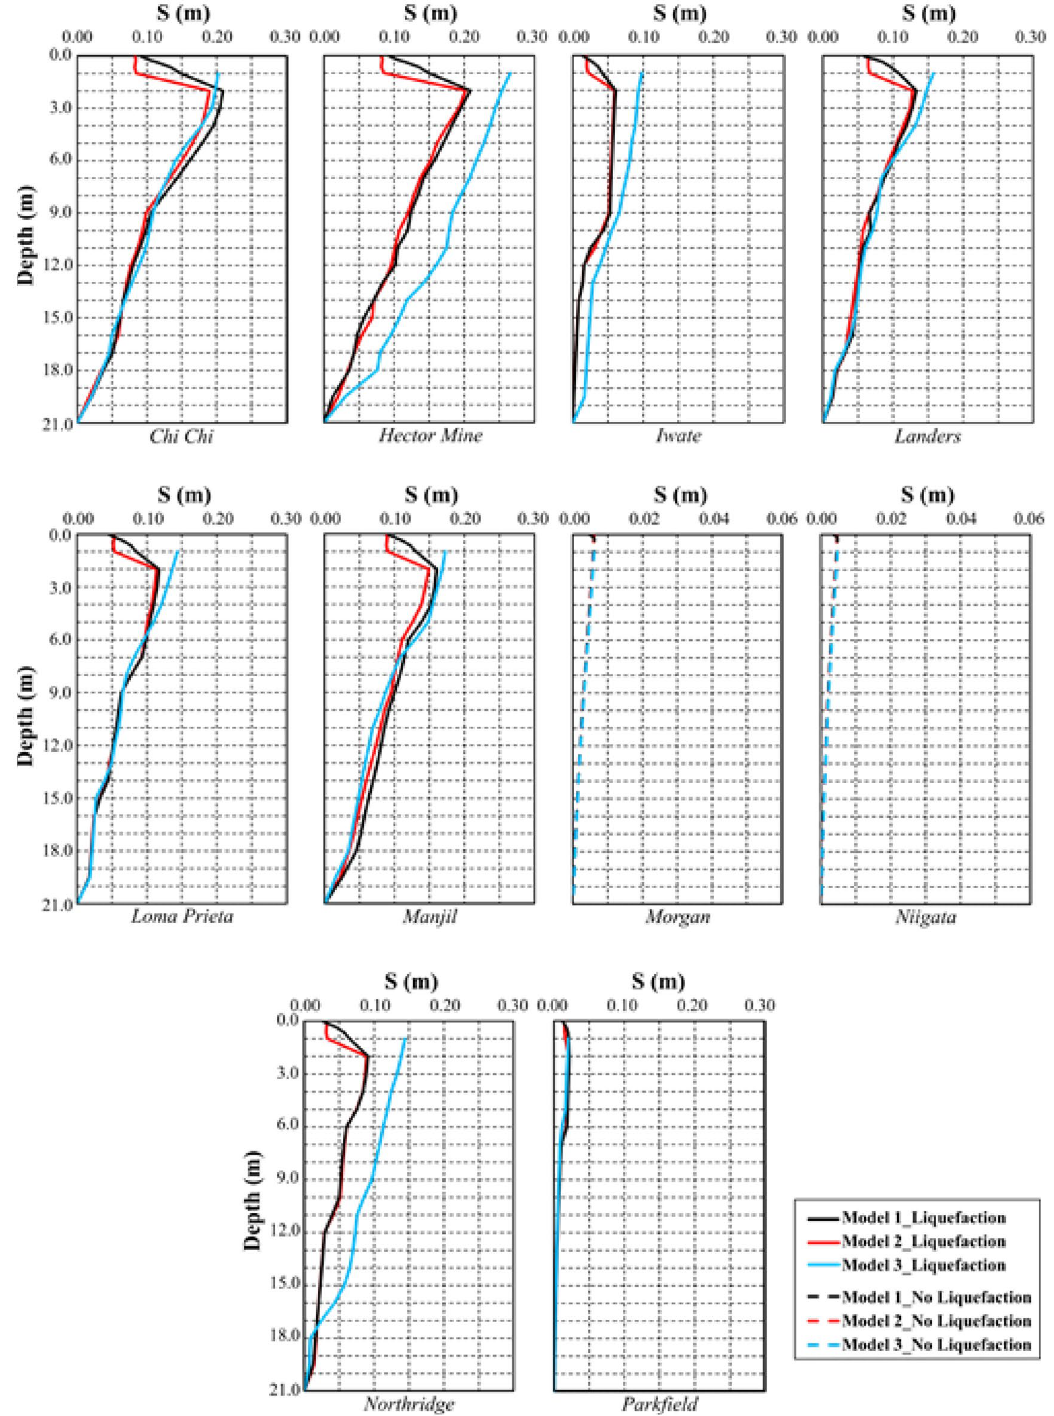
Figure 21. Change of liquefaction-induced settlement with depth for Model 1, 2 and